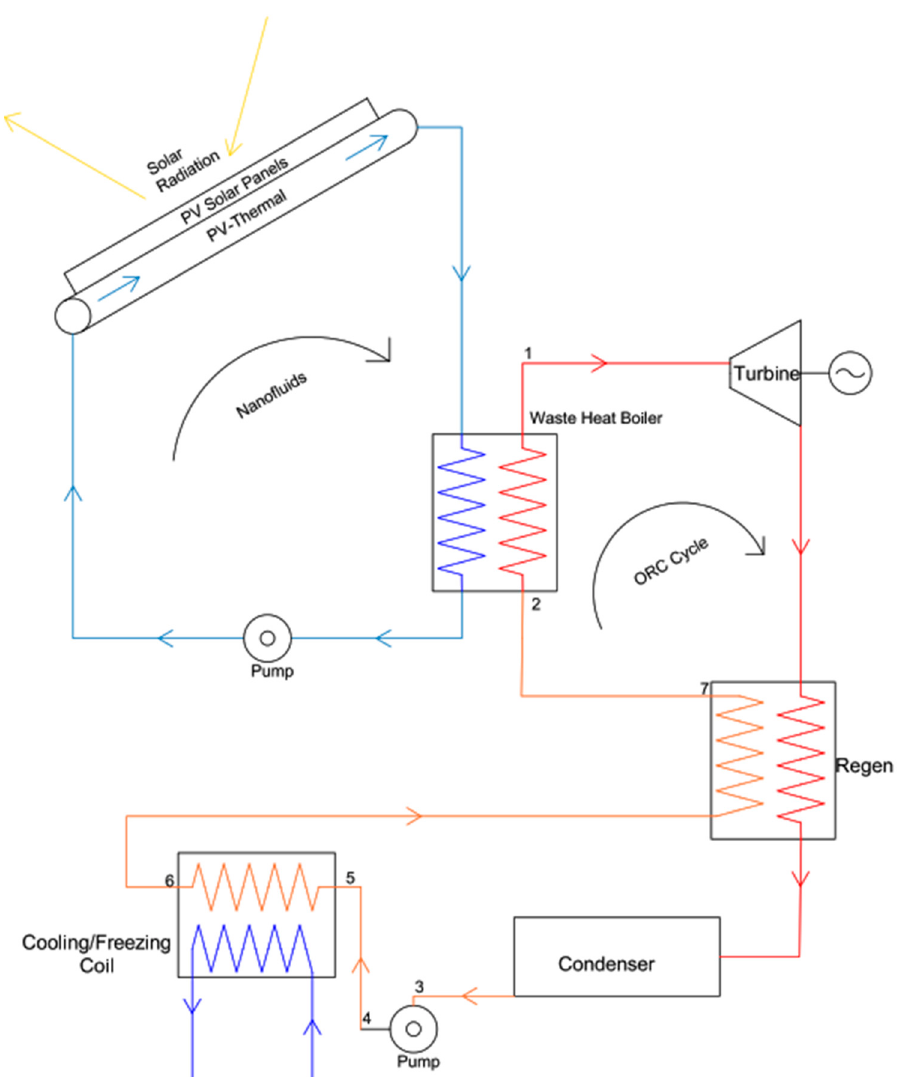
Figure 1. Organic rankine cycle with cooling capability.